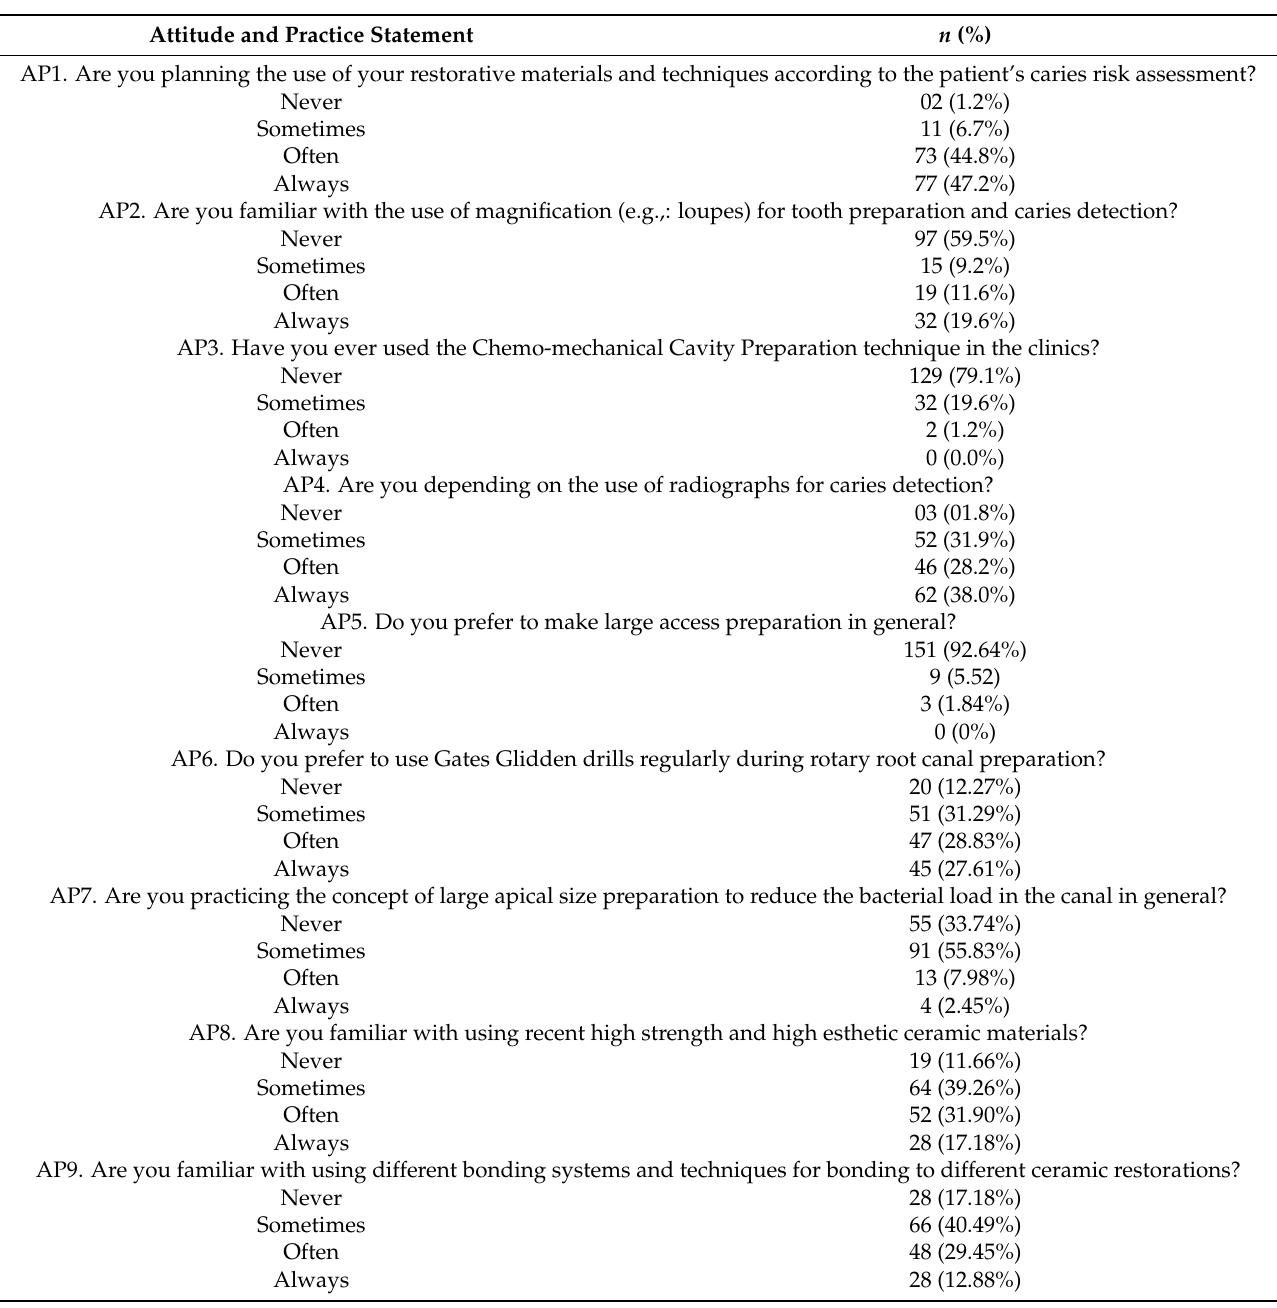
Table 3. Respondents’ responses to questions related to assessment of attitude and practice (AP) of